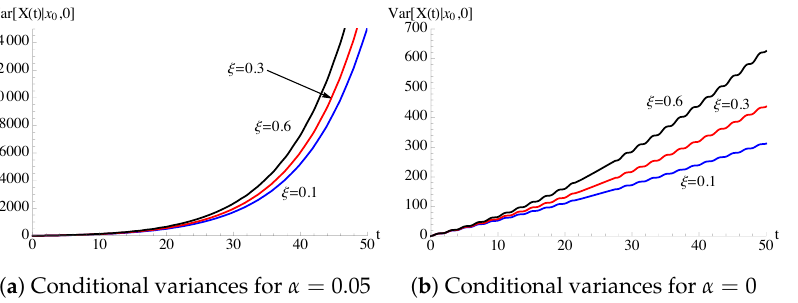
Figure 5. For the process of Figure 3, the conditional variances are plotted as function of t for various choices of ξ